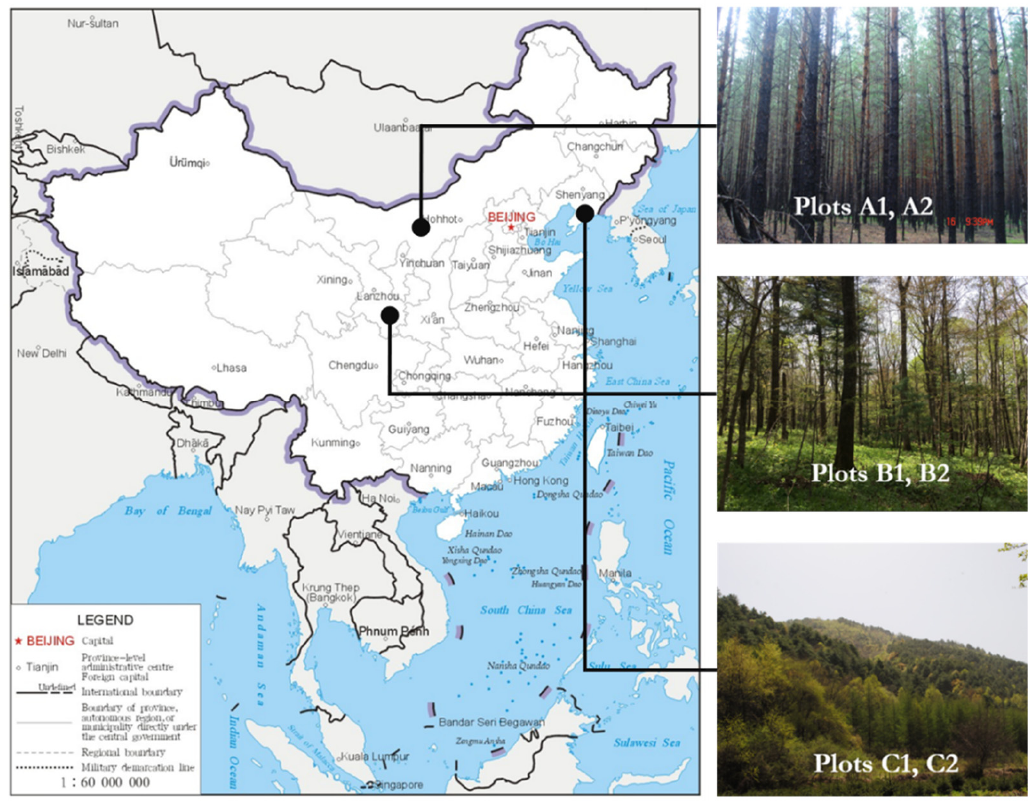
Figure 1. Location of the six plots.